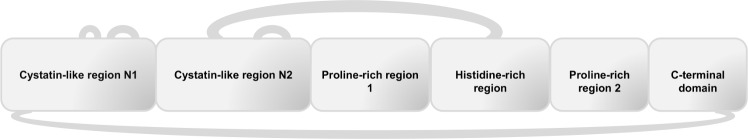
Schematic structure of HPRG.Schematic structure of the multiple domain structure of HPRG. Rabbit HPRG is supposed to possess five disulfide bridges according to [13].